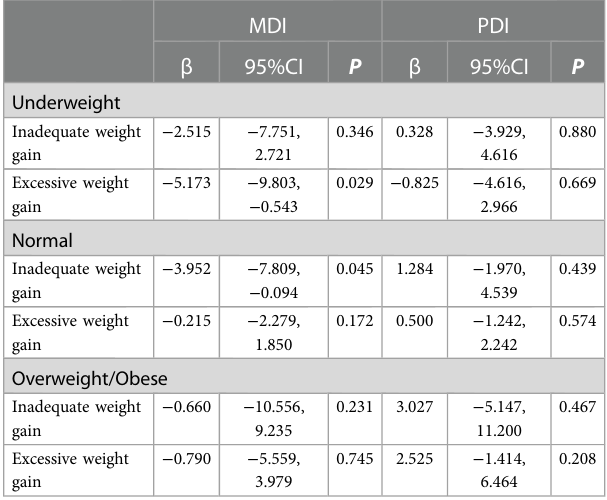
TABLE 3 Strati fi ed by pre-pregnancy BMI categories, infantile neurodevelopment at 2 years of age was compared in the various GWG categories.